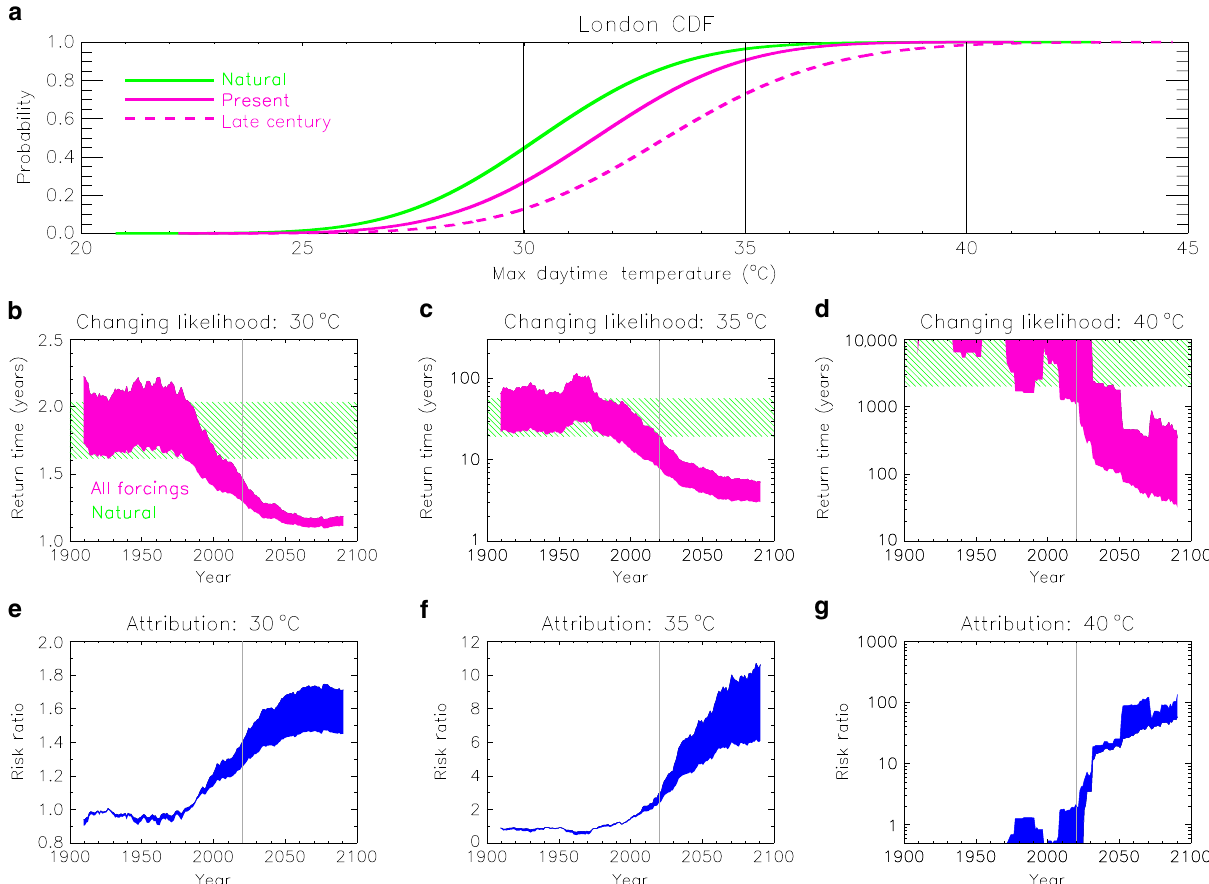
Fig. 6 Increasing chance of high-threshold exceedance illustrated for a location in London. a Cumulative distribution functions of the local warmest daytime temperature ( tx01 ) for the natural climate (green line), the present-day climate (pink solid line) and the climate of the late twenty- fi rst century (pink dashed line). The 30, 35 and 40 °C thresholds are marked by the vertical black lines. Panels b - d show timeseries of the return time (inverse probability) for the exceedance of the three thresholds with all forcings (in pink). The thickness of the timeseries illustrates the uncertainty in the transfer functions used in the analysis. The expected range in the natural climate is marked in green. Panels e – g show timeseries of the risk ratio (in blue) for the three thresholds, measuring the change in the likelihood of exceeding the threshold relative to the natural climate. The thickness of the timeseries represents the 5 – 95% uncertainty range. The vertical grey lines in panels b – g mark year 2020 (i.e., the present